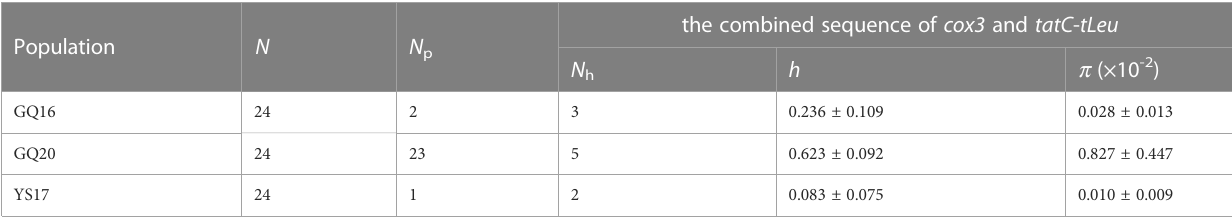
TABLE 1 Genetic diversity of three Chinese native populations of Undaria pinnati fi da estimated by using the combined sequences of cox3 gene and tatC - tLeu region.